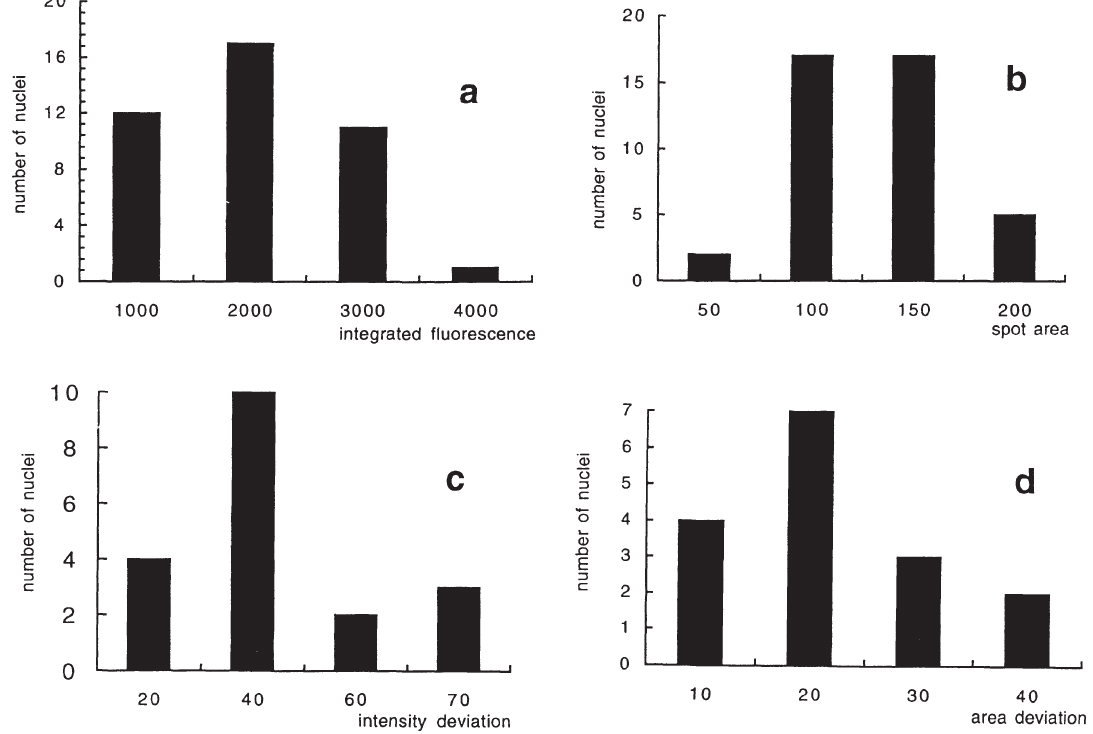
Fig. 2. Internuclear and intranuclear distribution of signal characteristics for 30 recorded nuclei (the shown example is for FITC, but is similar in all other cases). (a) Global (internuclear) distribution of the FISH spot intensity (in arbitrary units). (b) Global (internuclear) distribution of the FISH spot area (in pixels). (c) Intranuclear variation of spot intensities expressed in percentage of the standard deviation. (d) Intranuclear variation of spot areas expressed in percentage of the standard